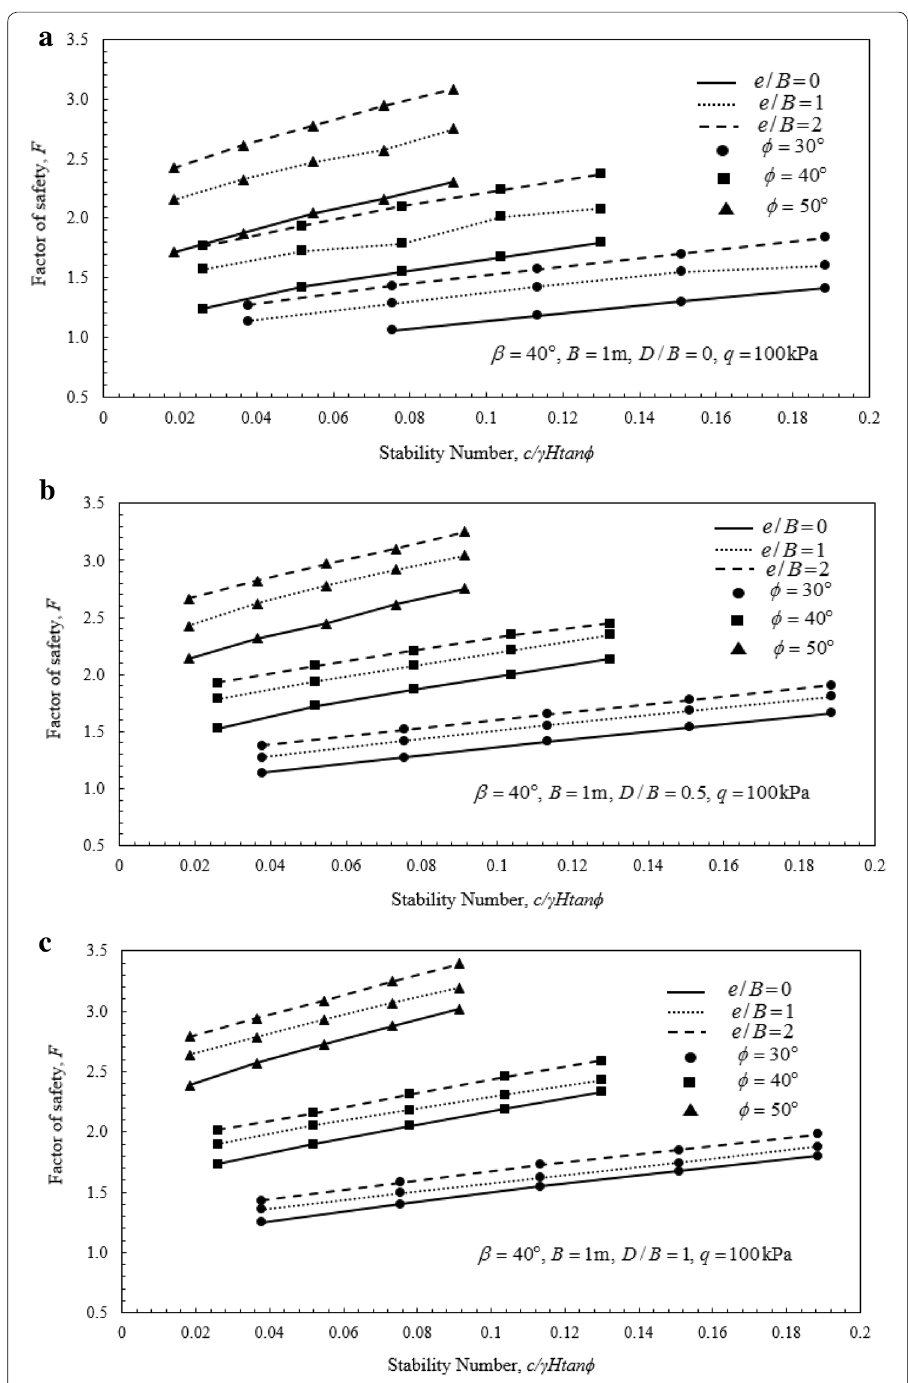
Fig. 14 Design charts for β = 40 ◦ : a D / B = 0 , b D / B = 0.5 , c D / B =